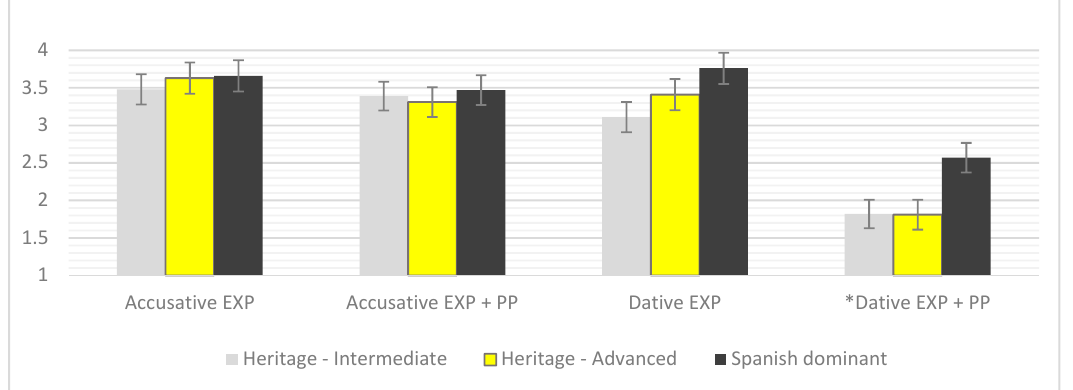
Figure 2. Judgment task with written stimuli—mean ratings for Class II verbs.